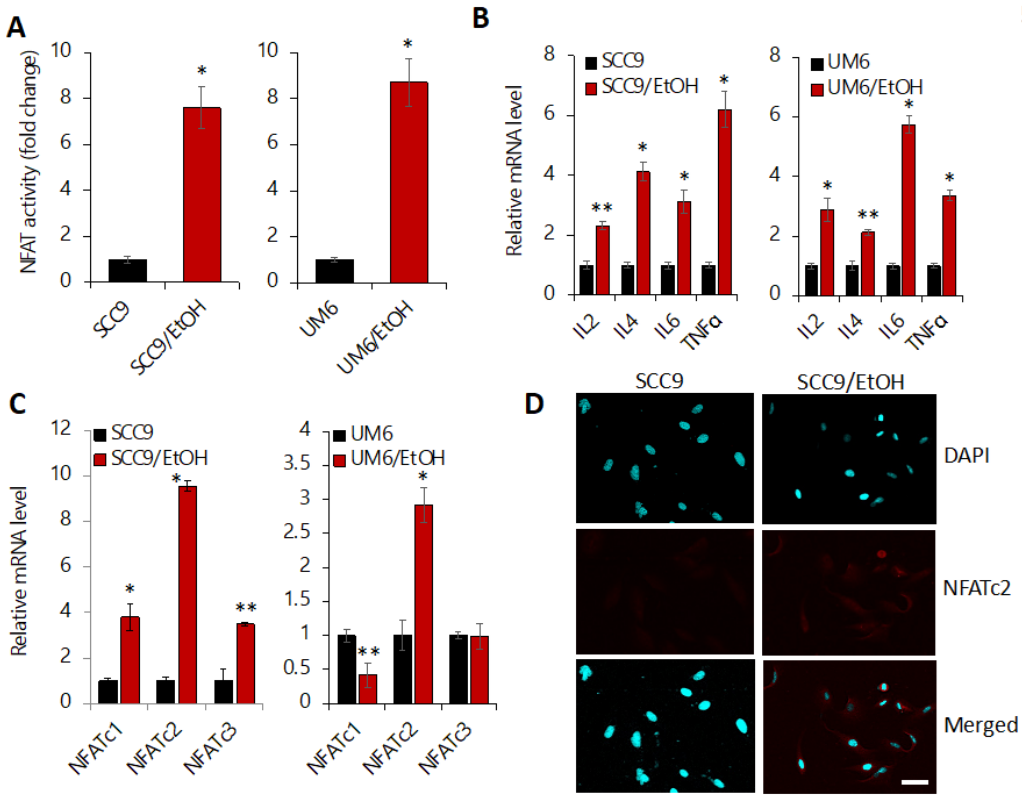
Figure 5. Chronic EtOH exposure activates NFAT signaling in OSCC. ( A ) Effect of chronic EtOH exposure on NFAT activity was determined by luciferase promoter assay. Cells were transfected with pGL3-NFAT-luc vector whose luciferase activity is under the control of a chimeric promoter containing three adjacent canonical NFAT binding sites. Cells were also transfected with pRL-SV40 for normalization of transfection efficiency. * p < 0.001. ( B ) Effect of chronic EtOH exposure on the expression of NFAT downstream targets (IL2, IL4, IL6, and TNF α ) in OSCC was determined by qPCR. * p < 0.001, ** p < 0.05. ( C ) Effect of chronic EtOH exposure on the expression of NFAT isoforms (NFATc1, NFATc2, and NFATc3) in OSCC was determined by qPCR. * p < 0.001, ** p < 0.05. ( D ) Effect of chronic EtOH exposure on the intracellular localization of NFATc2 was determined by confocal laser scanning microscopy. SCC9 has NFATc2 immunofluorescence staining (red) mainly in the cytoplasm while SCC9/EtOH has stronger staining both in the cytoplasm and the nucleus, which indicates increased NFATc2 expression, as well as dominant nuclear translocation. Bar, 20 μ m.